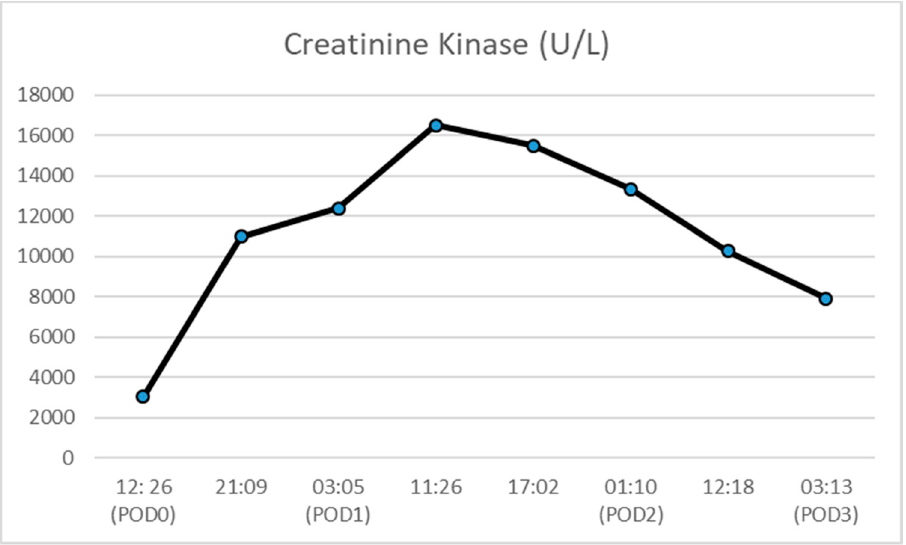
Figure 3. Creatinine kinase concentration (POD = post-operative day).